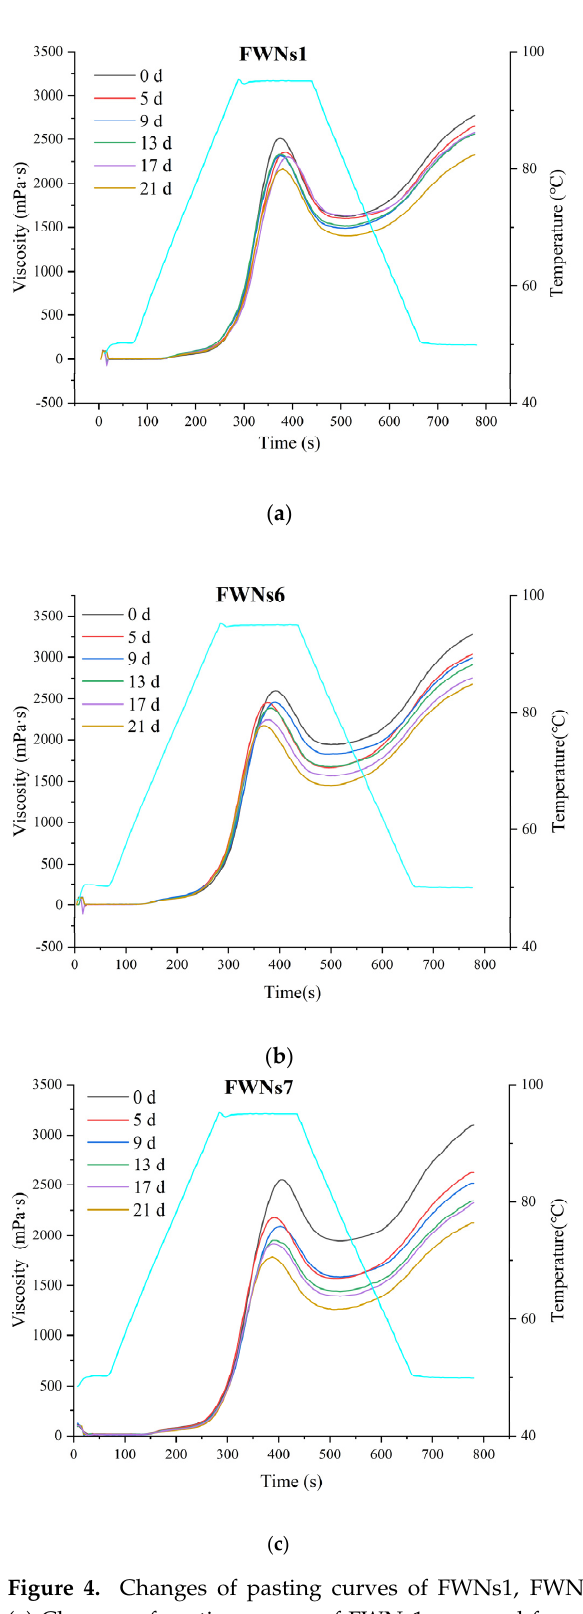
Figure 4. Changes of pasting curves of FWNs1, FWNs6 and FWNs7 during storage at 4 °C. ( a ) Changes of pasting curves of FWNs1 prepared from F1 during storage; ( b ) Changes of pasting curves of FWNs6 prepared from F6 during storage; ( c ) Changes of pasting curves of FWNs7 prepared from F7 during storage.